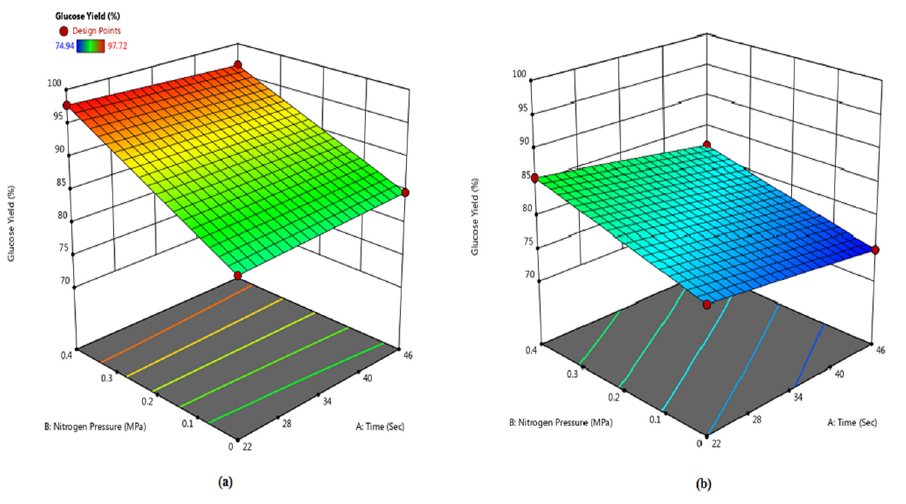
Figure 4. Response surface of glucose yield in solid fraction ( a ) 4 g biomass loading ( b ) 8 g biomass loading.